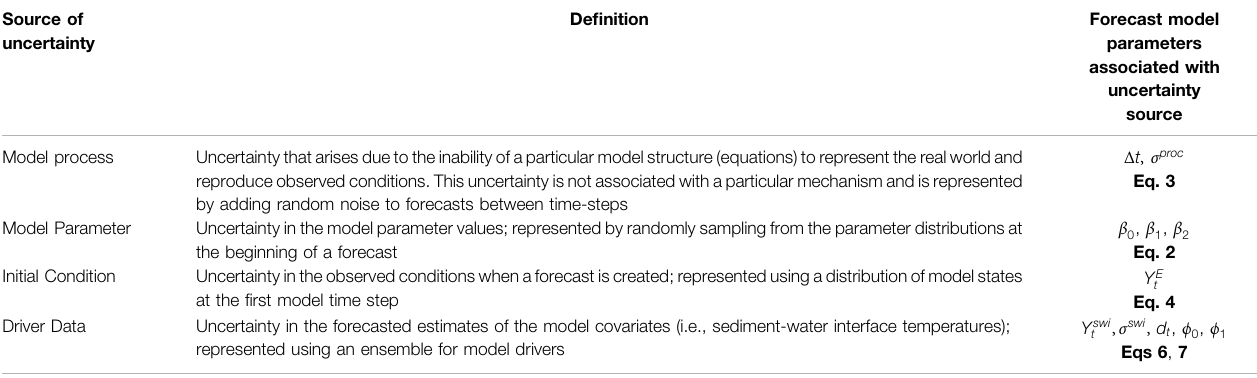
TABLE 1 | De fi nitions of uncertainty sources that can contribute to total forecast uncertainty and what parameter and variables from the Eqs 2 , 3 , 4 , 6 , 7 correspond to the total uncertainty (derived from Dietze, 2017a). Source of uncertainty